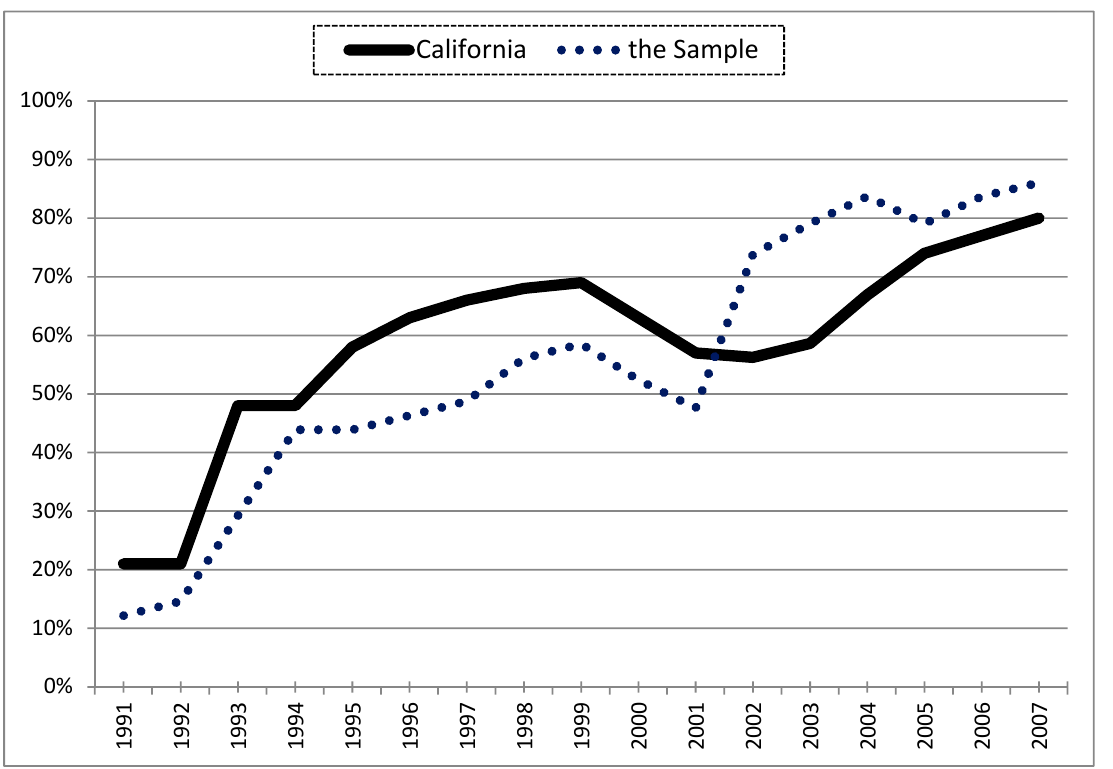
Figure A1. Annual compliance of California and the sample cities. The period of study is from 1998 to 2005. source: [99].